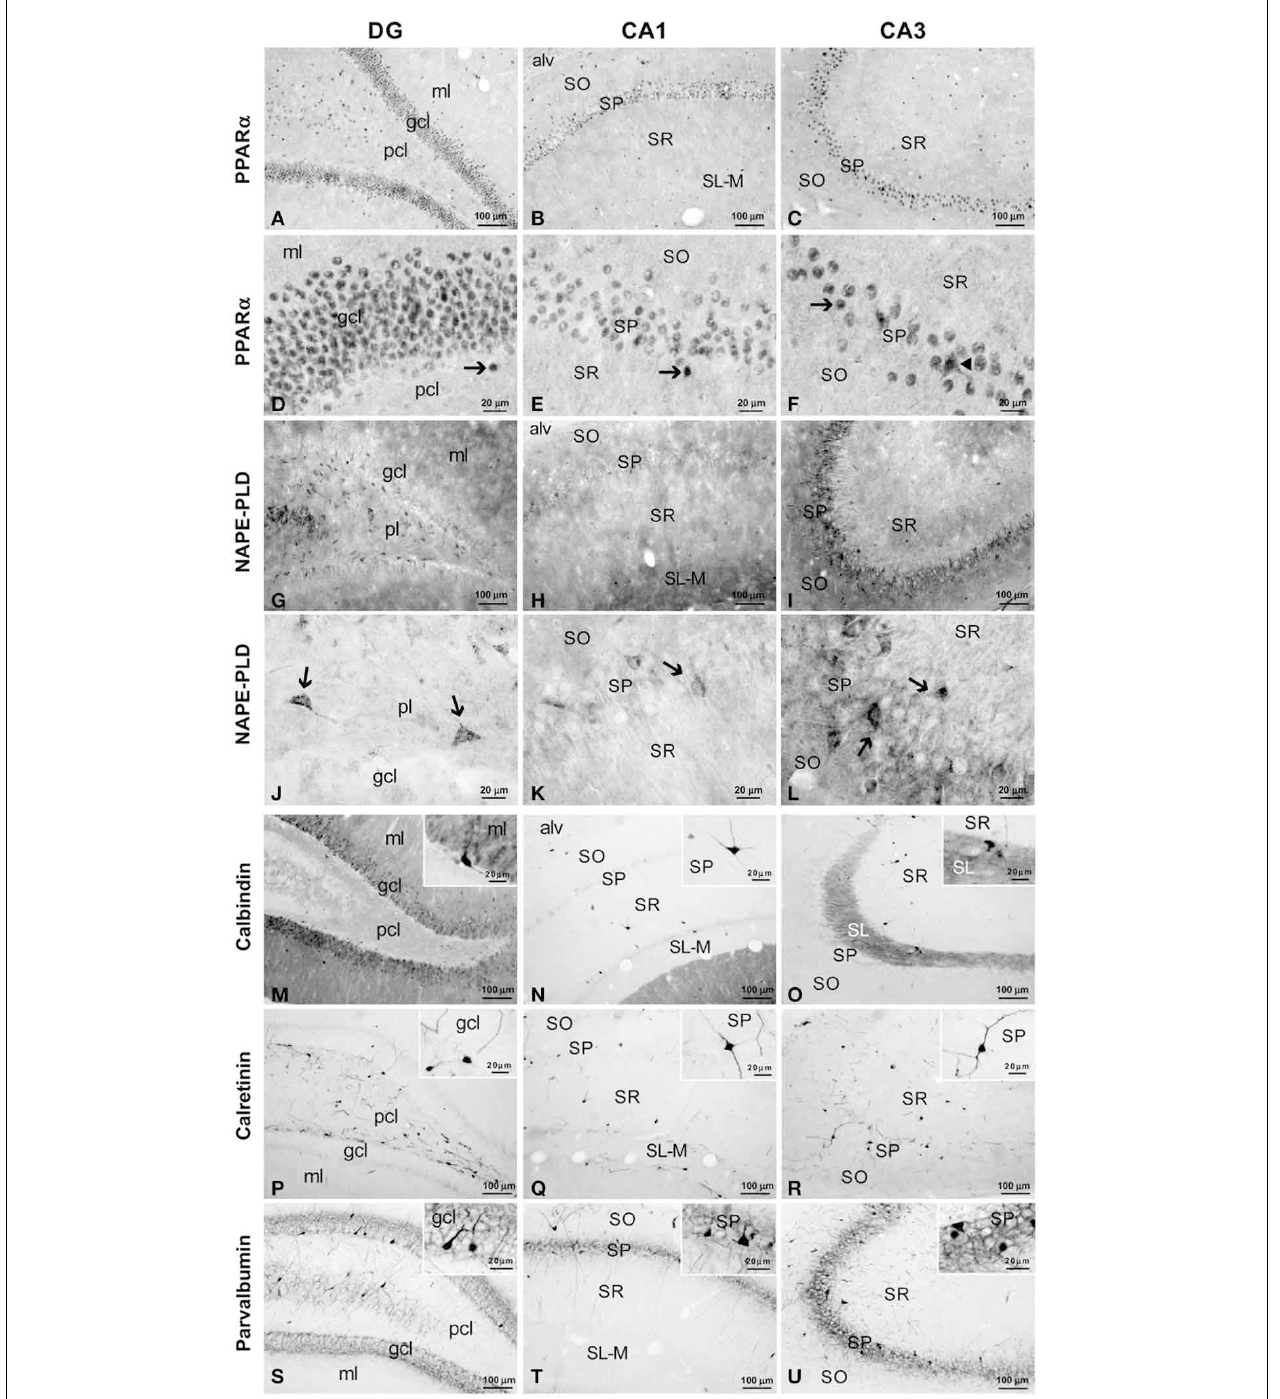
the DG and the SP of the CA1/3 fields. (M–O) Fibers in the ml of the DG and the SL of CA3 and cells in the gcl of the DG and the SO, SP, and SR of the CA1/3 fields were stained for calbindin. (P–R) A discrete number of cells in the pcl of the DG and all strata of the CA1/3 fields expressed calretinin. (S–U) Cells stained for parvalbumin were found in the gcl of the DG and the SP and SO of the CA1/3 fields, whereas fibers were observed in the gcl of the DG and the SP of the CA1/3 fields. For abbreviations, see Table 3 legend. Scale bars are indicated in each